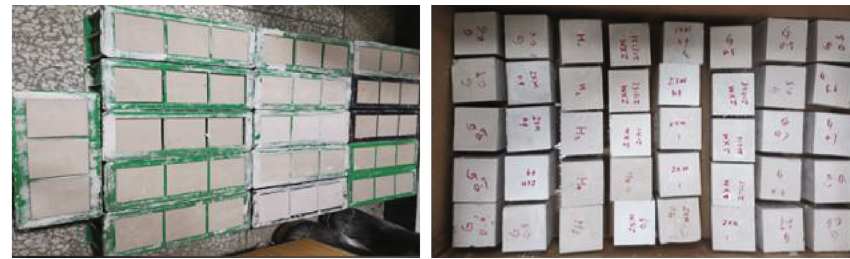
Figure 4: Production and maintenance of cube samples with di ff erent proportions. Table 2: Material ratio and properties of gypsum